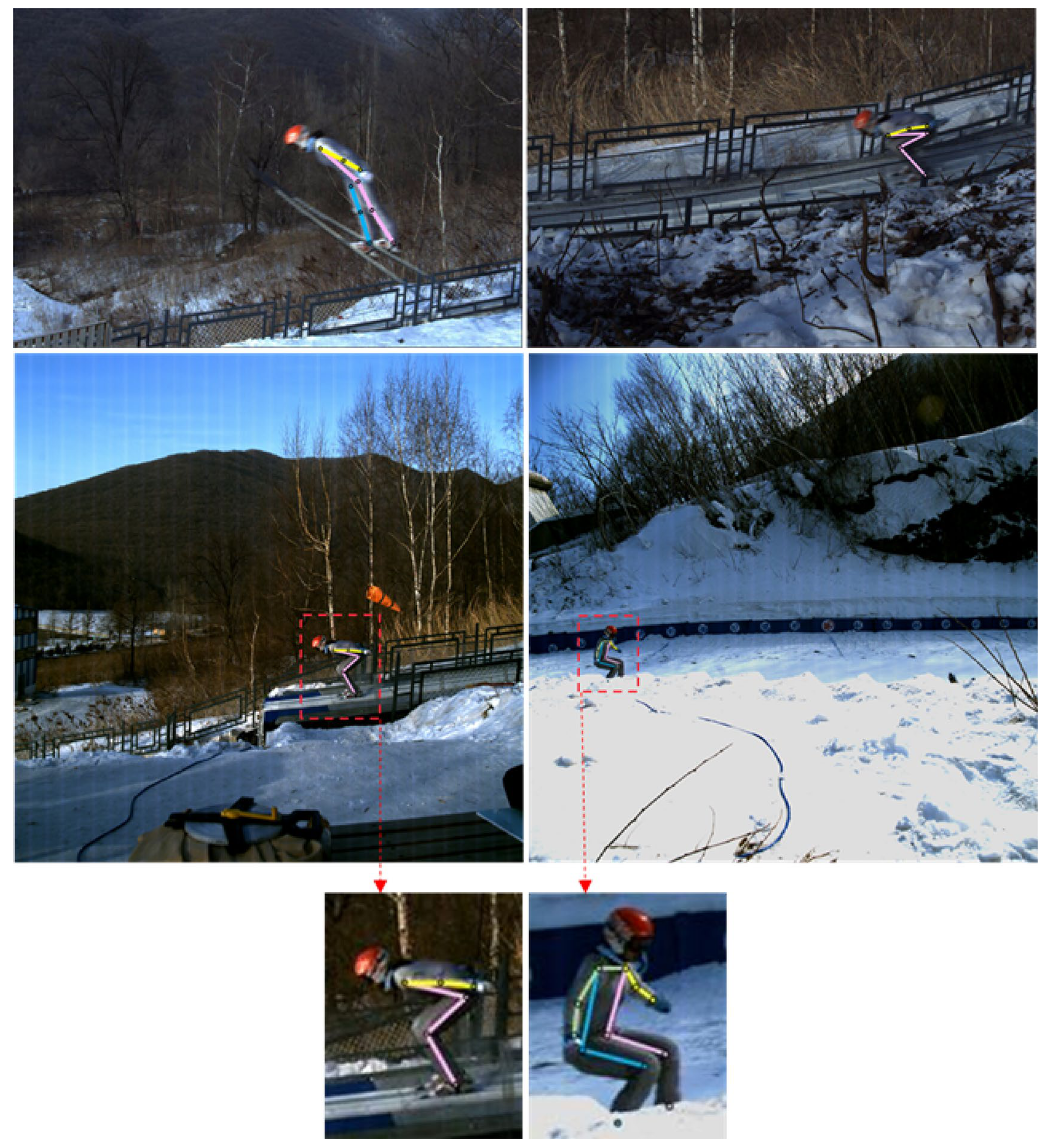
Figure 11. Visualization of results on the KDSJ validation